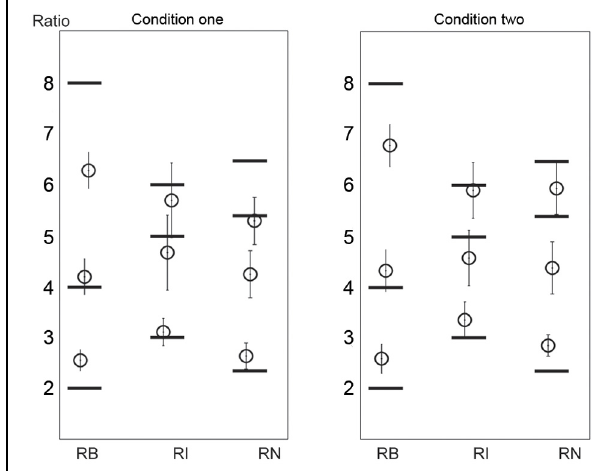
FIGURE 8 | Reproduced ratios. Horizontal black lines mark the presented ratios. Error bars indicate ± 95% confidence intervals. RB, RI, and RN represent rhythms formed with b inary, non-binary i nteger, and n on-integer ratios,